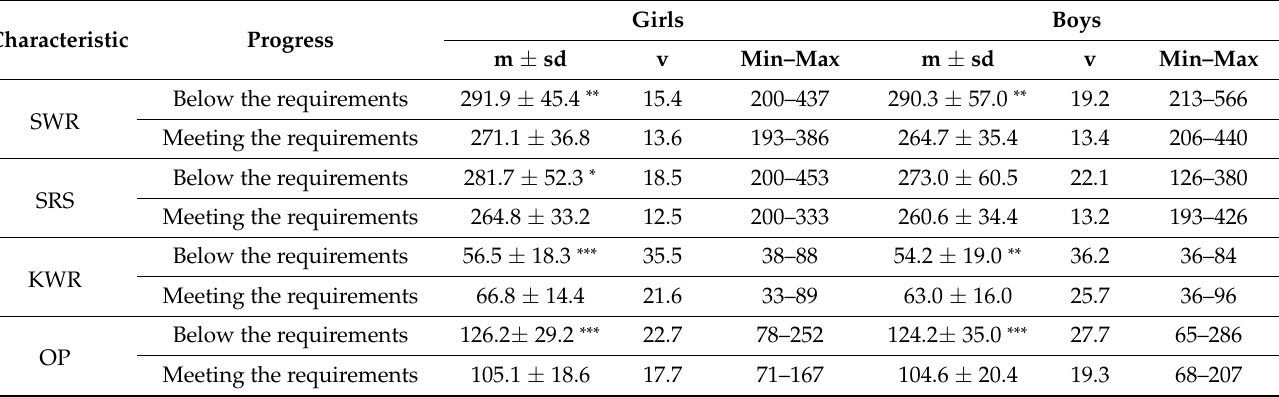
Table 6. Coordination motor abilities in 10-year-old children in swimming progress